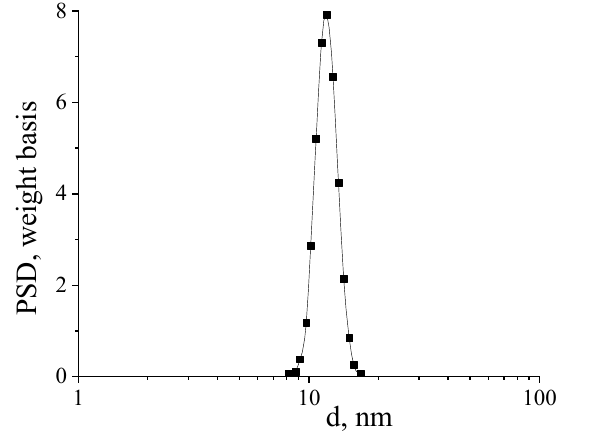
Figure 4. Histogram of particle size distribution in a suspension of a CeO 2 sample redispersed in water.